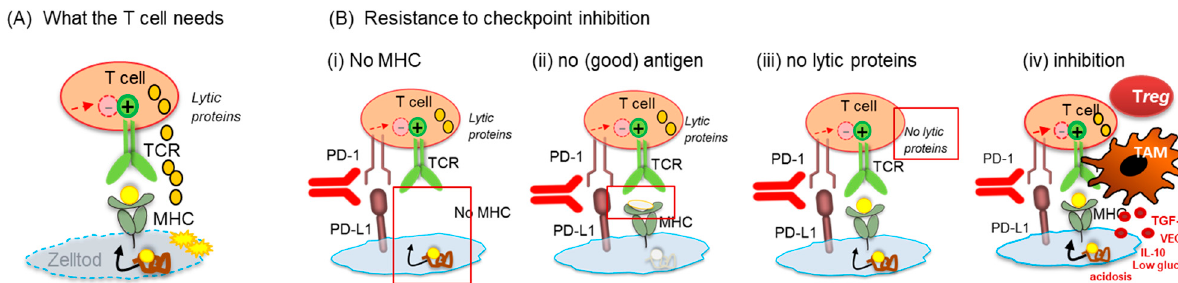
Figure 3. What the T cells need—prerequisites for responsiveness to ICI ( A ) and resistance mechanisms ( B ): ( A ) For the T cell to be an effective killer, it requires a positive signal through the T cell receptor (TCR), which must be provided by the tumor cell through MHC-presented antigens. If the TCR is triggered successfully, the T cell can kill the target cell if the T cell expresses lytic proteins (perforin or granzymes). ( B ) The T cell cannot be a killer (even if the PD-1/PD-L1 pathway is de-blocked by an antibody) if the tumor cell has no MHC (i), if the tumor cell has no (good) antigen (ii), if the T cell has no lytic proteins (iii), or if suppressor cells (tumor-associated macrophages (TAM) or regulatory T cells (Tregs)), or a combination of any one of these conditions, are present in the neighborhood of the T cells (iv).